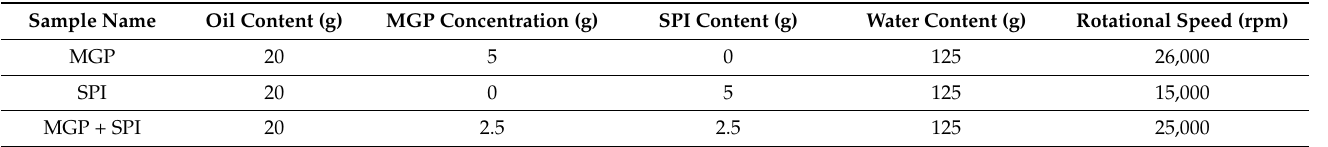
Table 1. Composition of coconut oil-in-water emulsions. MGP refers to microgel particles, SPI refers to soy protein isolate.